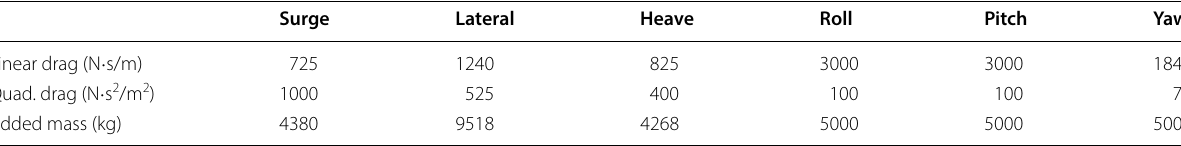
Table 1 Hydrodynamic parameters Surge